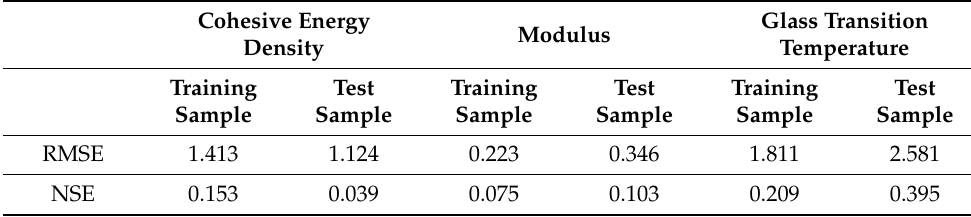
Table 2. Root mean squared error (RMSE) and normalized squared error (NSE) on the training and test sets for predicting the cohesive energy, modulus, and glass transition temperature using the ANN